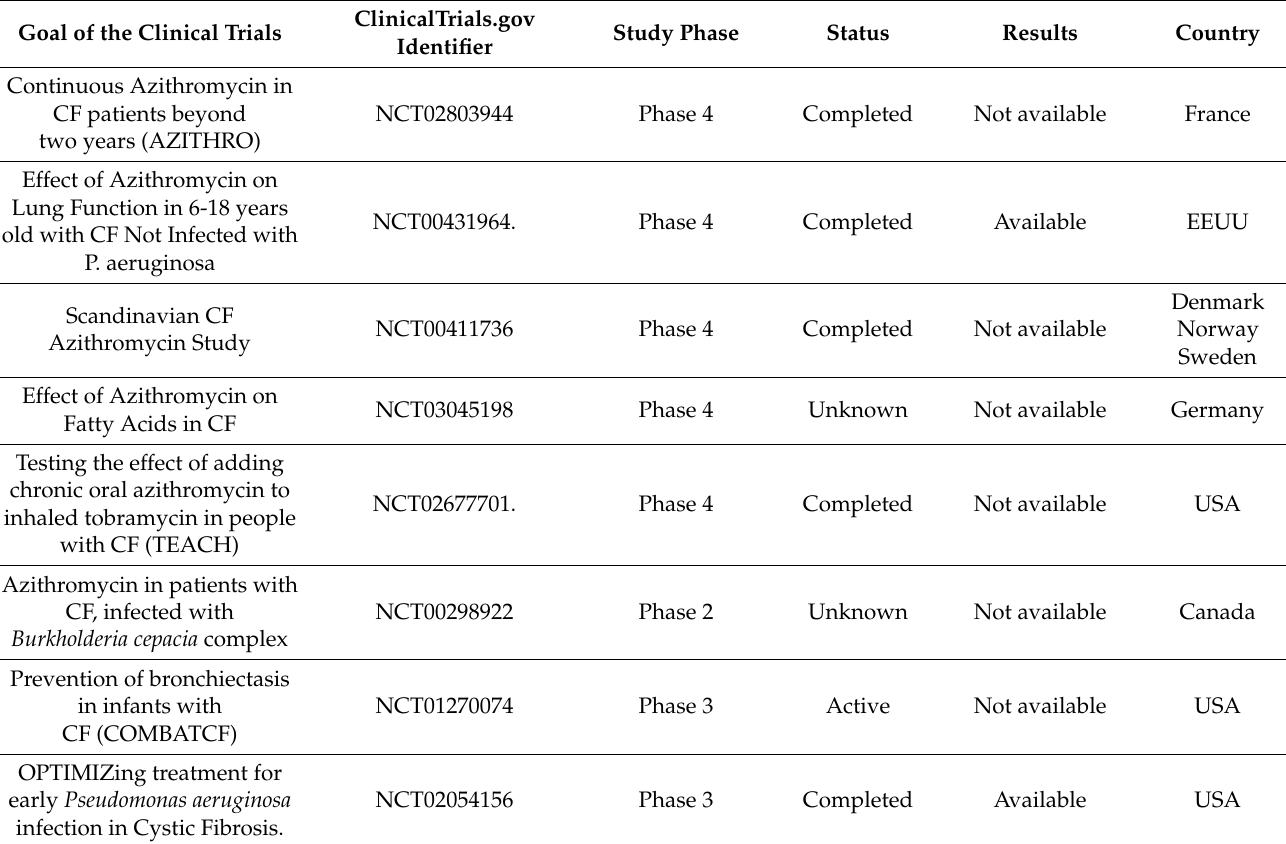
Table 2. Clinical trials about the use of azithromycin in patients with